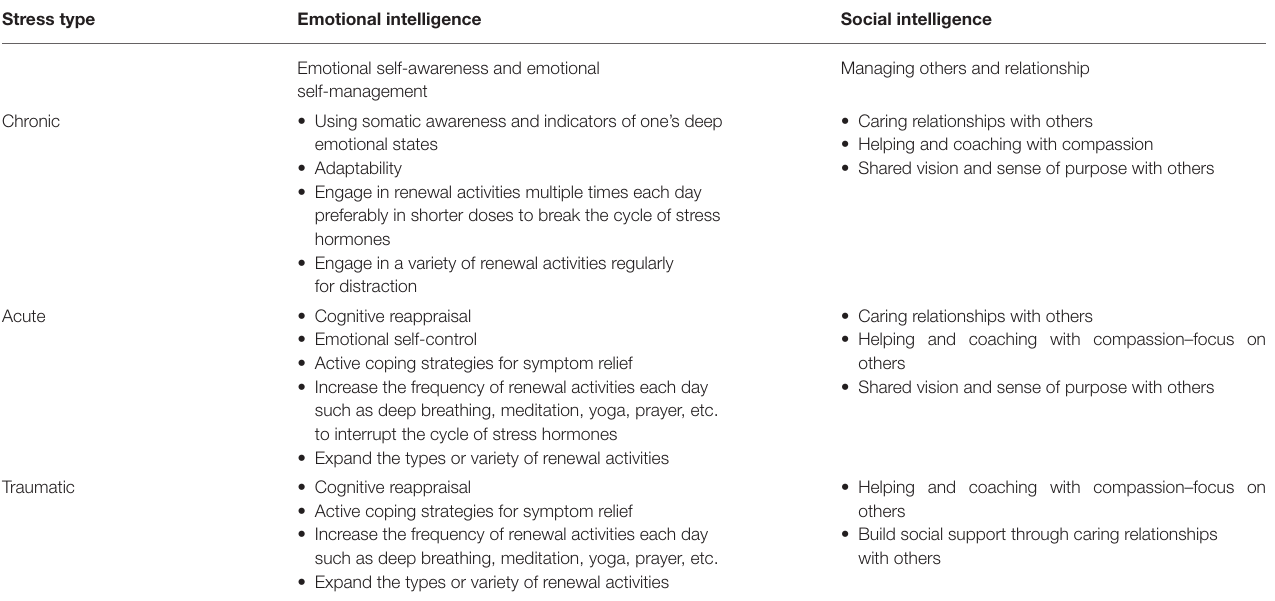
TABLE 1 | Most relevant ESI competencies and activities ameliorating different types of